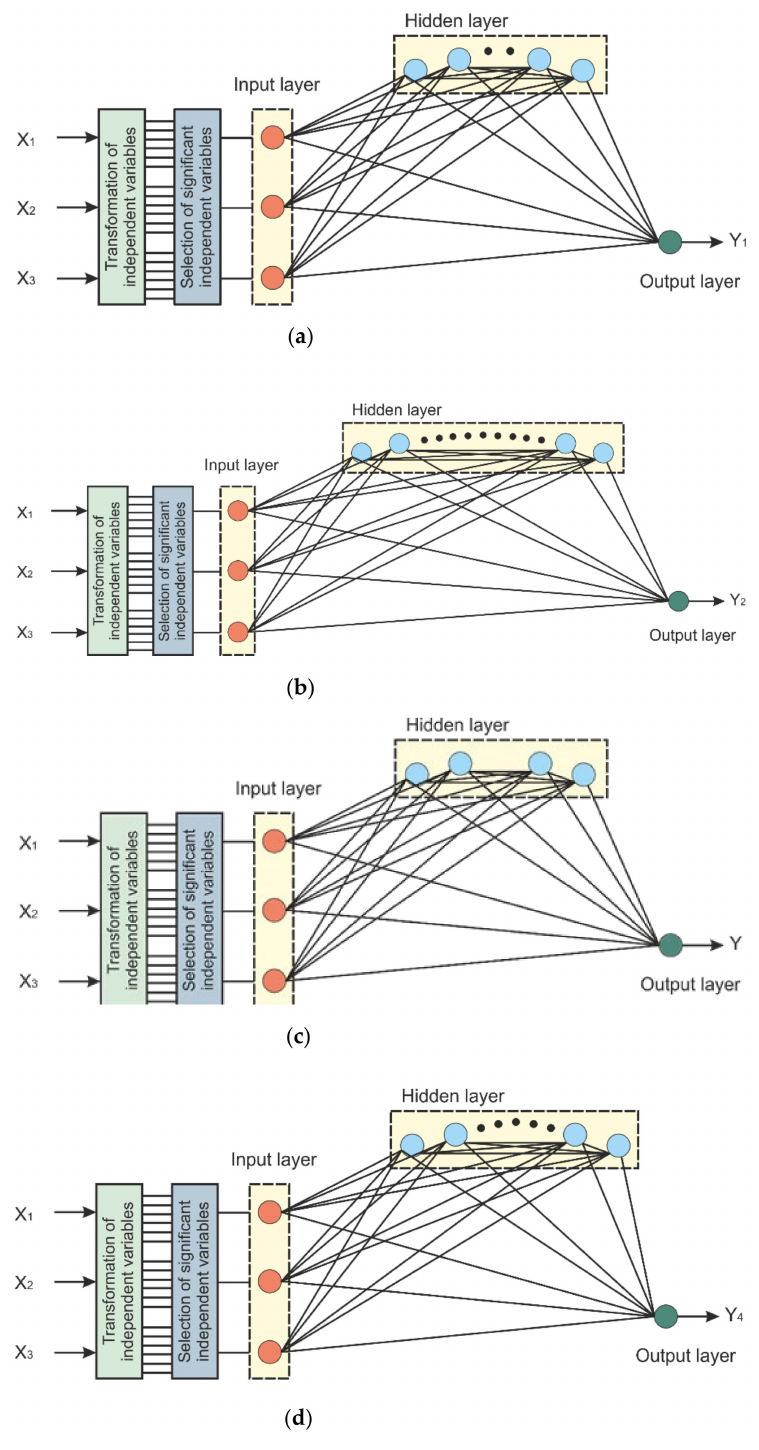
Figure 1. The optimum structure of developed cascade ANN models that could predict the: ( a ) delamina- tion factor at the outlet; ( b ) delamination factor at the inlet; ( c ) thrust force; ( d ) drilling